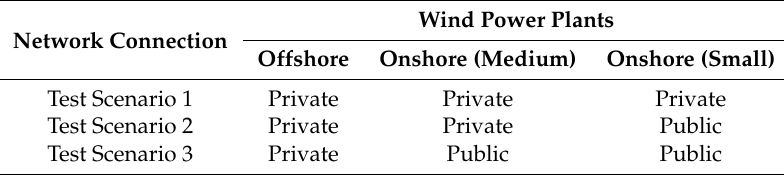
Table 3. Test Scenarios based on Network